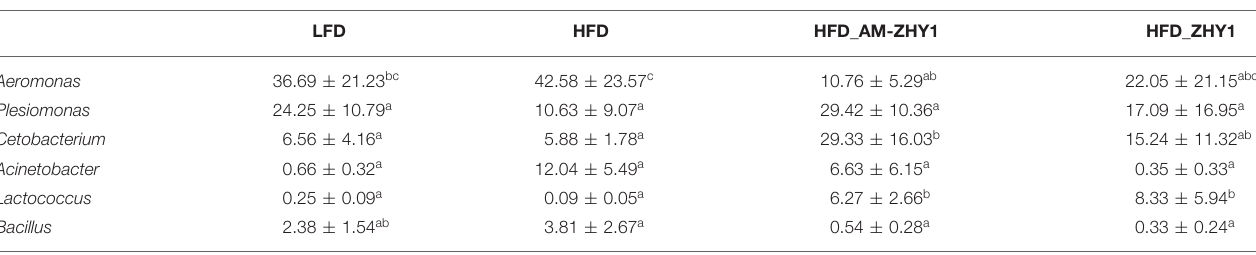
TABLE 5 | The relative abundance of each group of intestinal flora at the genus